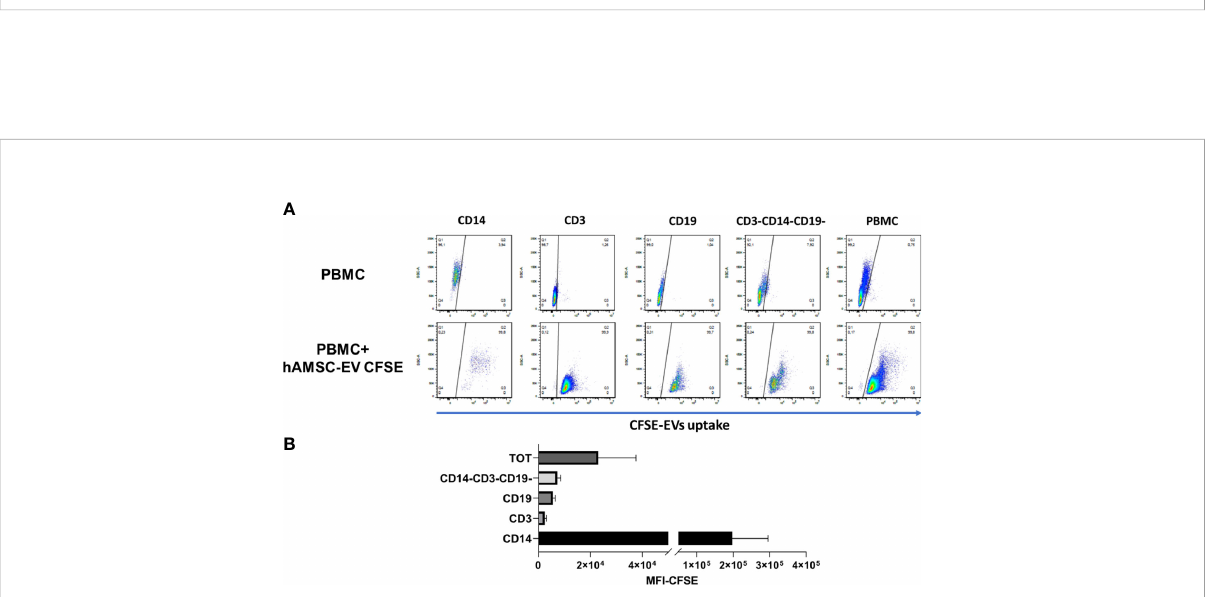
FIGURE 6 Flow cytometry analysis of hAMSC EV uptake by PBMC (A) PBMC were cultured without stimulation in presence or absence of 5 × 10 9 EVs loaded with CFSE to evaluate uptake. A staining for the different immune subsets was performed to evaluate differences in the uptake capability. (B) Mean fl uorescence analysis of the different immune subpopulations normalized on the negative